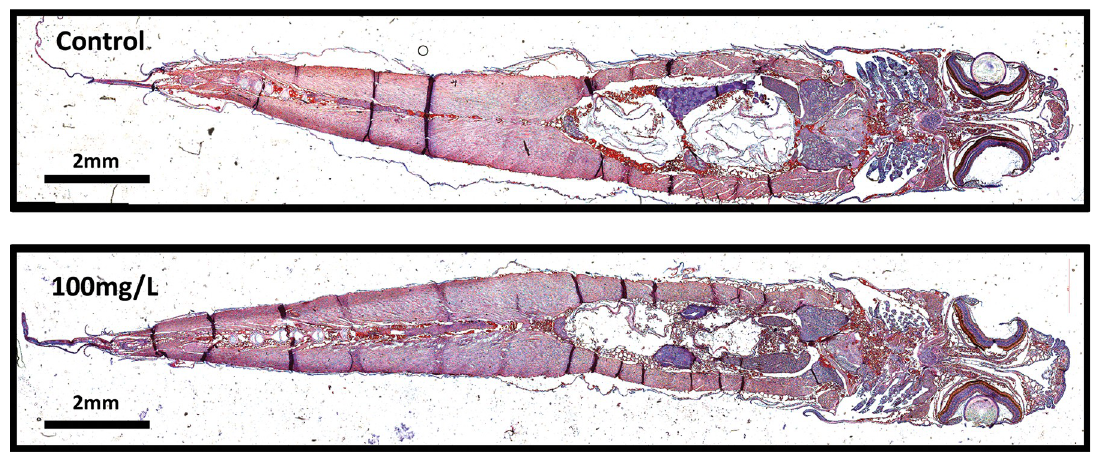
Fig 1. Whole-body lipid accumulation is not affected by perchlorate exposure in zebrafish. Lipid (bright red stain) appears around the gills, peritoneal cavity and around the spinal cord in both control and perchlorate treated zebrafish. Slides were frontally sectioned at 10 μ m and stained with oil red O and hematoxylin.